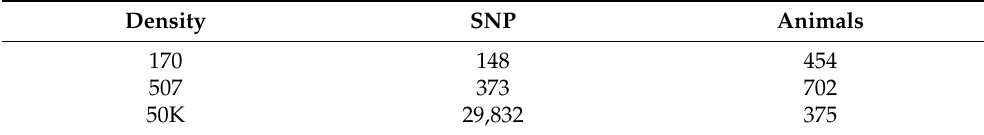
Table 2. Number of SNPs and animals after quality control for 170, 507 and 50K SNPs. Density SNP Animals 170 148 507